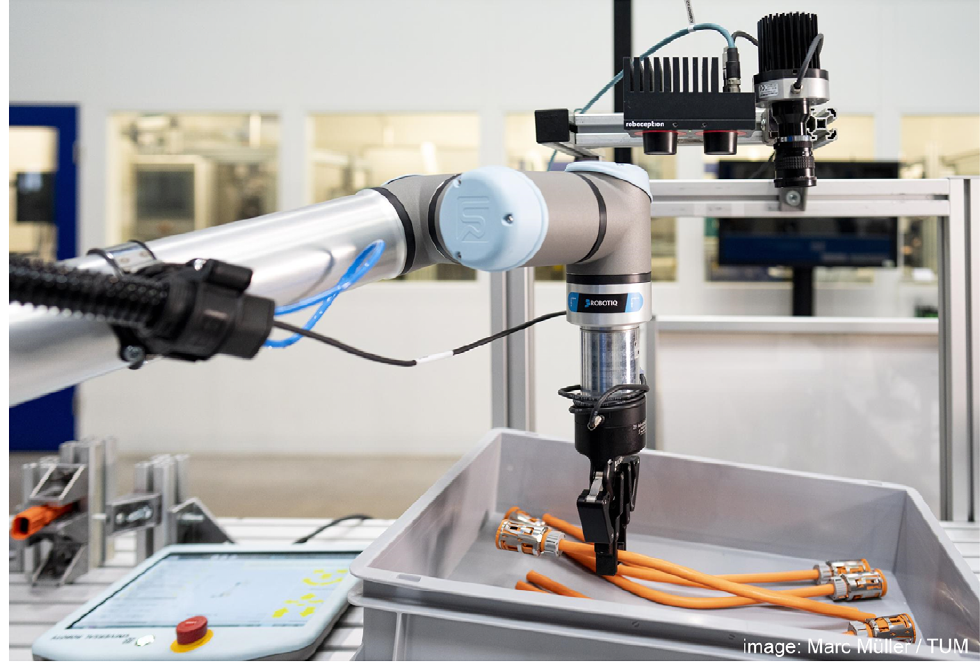
Figure 4. Illustration of the industrial use case of providing DLOs in a small load carrier to a robotic